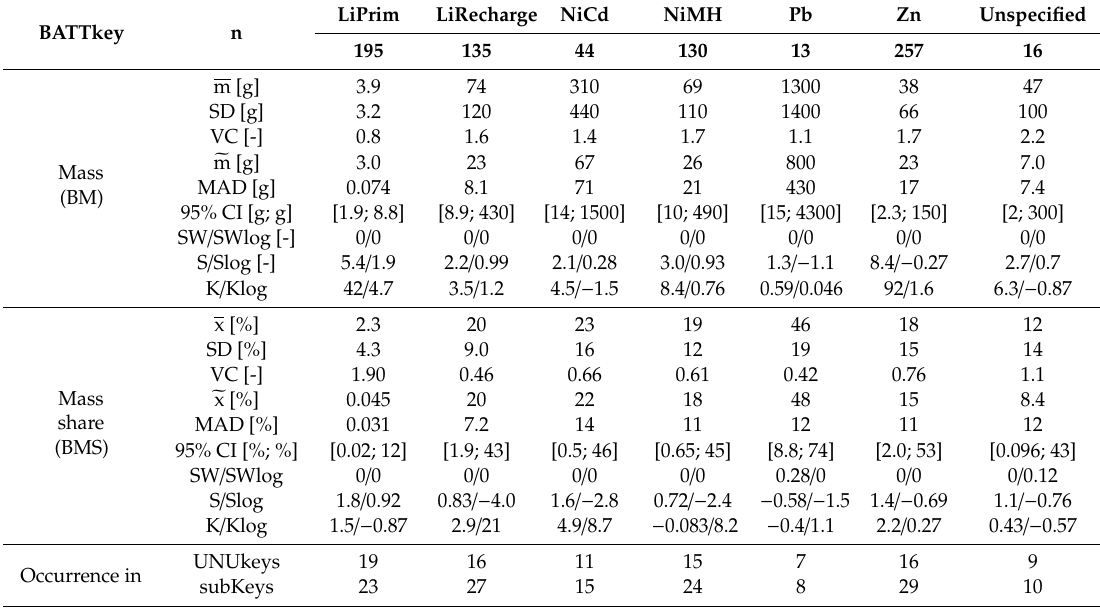
Table A1. Battery mass and mass share di ff erentiated by